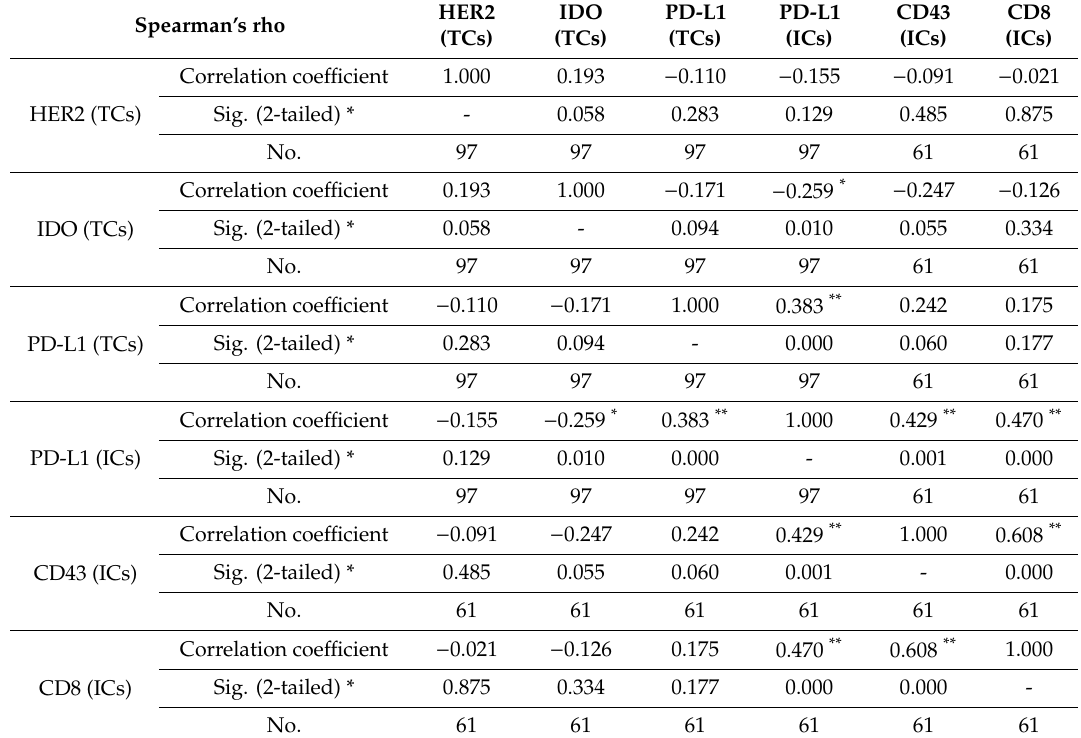
Correlations between HER2, IDO, PD-L1, CD43, and CD8 expression according to immunohistochemical staining of urothelial carcinoma of the